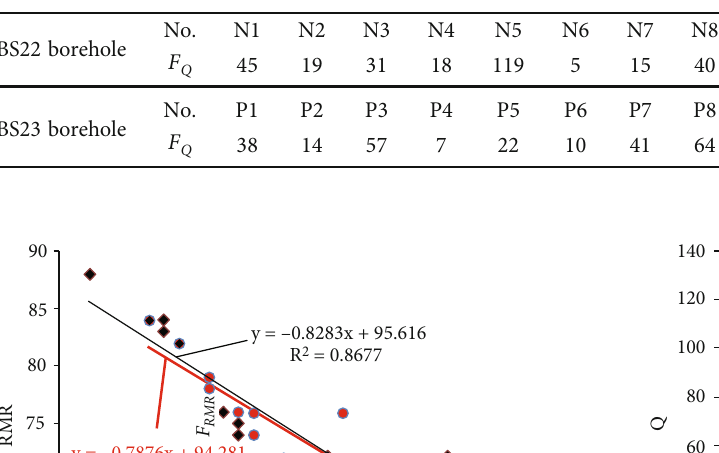
Table 9: F Q values of the outcrops around BS22 and BS23 boreholes.